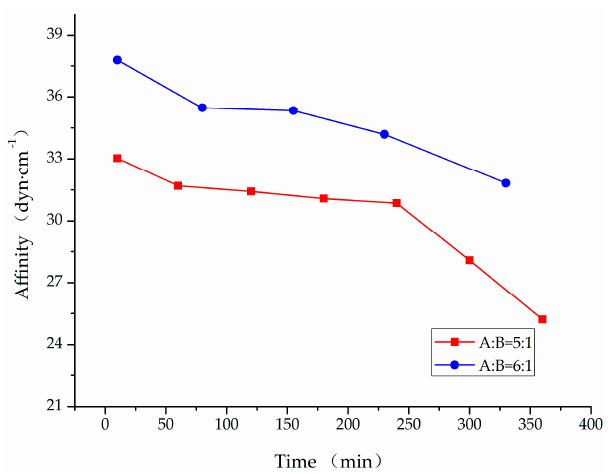
Figure 8. The change curve of affinity of the slurry.